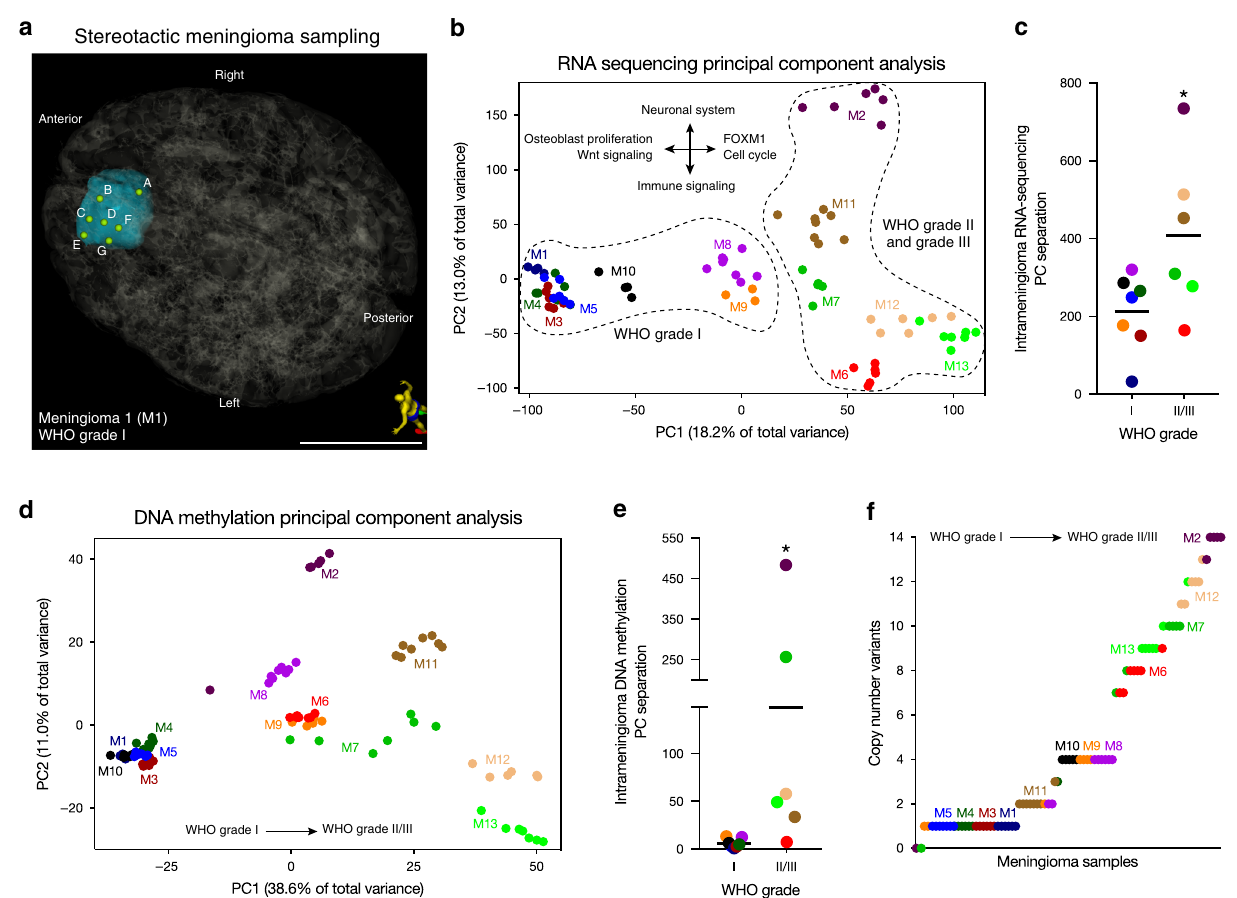
Fig. 1 Transcriptomic, epigenomic, and genomic intratumor heterogeneity in meningioma. a 3D stereotactic meningioma sampling map for seven samples ( a – f ) from a primary WHO grade I meningioma (M1) reconstructed from preoperative MR imaging. Patient orientation is represented by the model on the bottom right. Scale bar, 5 cm. b RNA sequencing principal component (PC) analysis reveals that approximately 31% percent of variation among samples from the 13 meningiomas obtained for this study is explained by the fi rst two principal components. WHO grade I meningiomas are uni fi ed by expression of genes associated with osteoblast proliferation and Wnt signaling. WHO grade II and grade III meningiomas are uni fi ed by expression of FOXM1 target genes and cell cycle effectors, and distinguished by expression of either neuronal system or immunologic genes in the second PC. c Intratumor RNA sequencing PC separation reveals greater heterogeneity within WHO grade II and grade III meningiomas than within WHO grade I meningiomas. d DNA methylation PC analysis reveals that approximately 50% of variation among samples from the meningiomas obtained for this study is explained by the fi rst two principal components. e Intratumor DNA methylation PC separation con fi rms greater heterogeneity within WHO grades II and III meningiomas than within WHO grade I meningiomas. f Copy number variants derived from DNA methylation analysis reveals greater genomic instability within WHO grade II and grade III meningiomas than within WHO grade I meningiomas. Horizontal lines c , f represent means. * P ≤ 0.05, two-tailed Student ’ s unpaired t test. Samples from spatially distinct meningioma samples are color-coordinated by